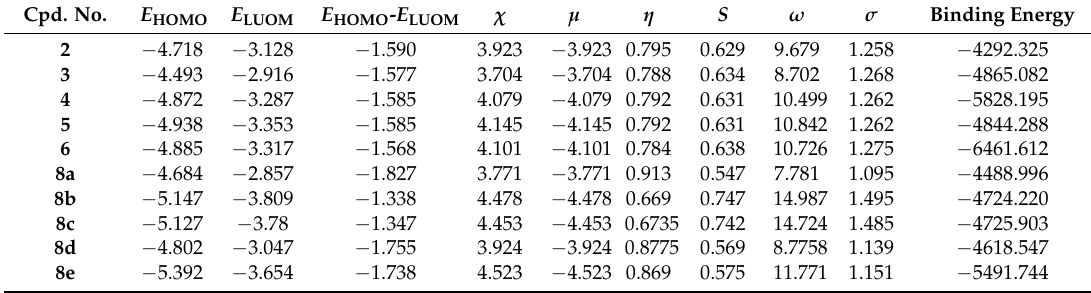
Table 1. Calculated EHOMO, ELUMO, electronegativity ( χ ), chemical potential ( µ ), global hardness ( η ), global softness ( S ), global electrophilicity index ( ω ) and softness ( σ ) for thiazole derivatives complexes. Cpd.